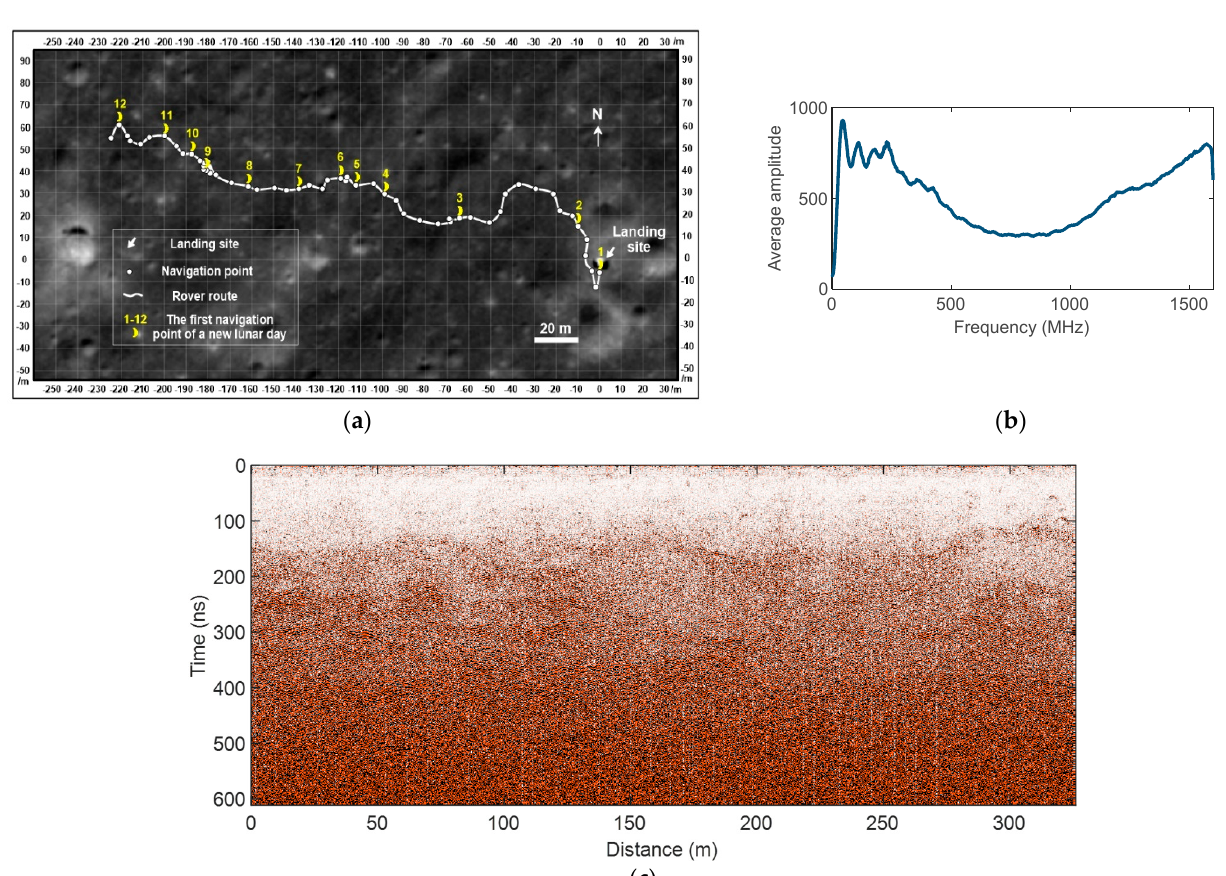
Figure 1. ( a ) The traveling route of Yutu-2 rover within the first 12 lunar days [11]. ( b ) The initial CH-2B LPR radargram acquired along the path in ( a ) without filtering. ( c ) The average frequency amplitude spectrum of the radargram in ( b ), which is masked by low-frequency clutter and high-frequency noise of large quantities.